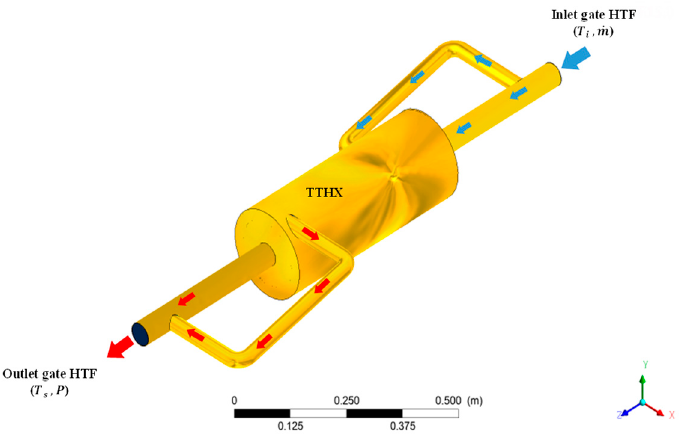
Figure 1. TTHX geometric configuration.